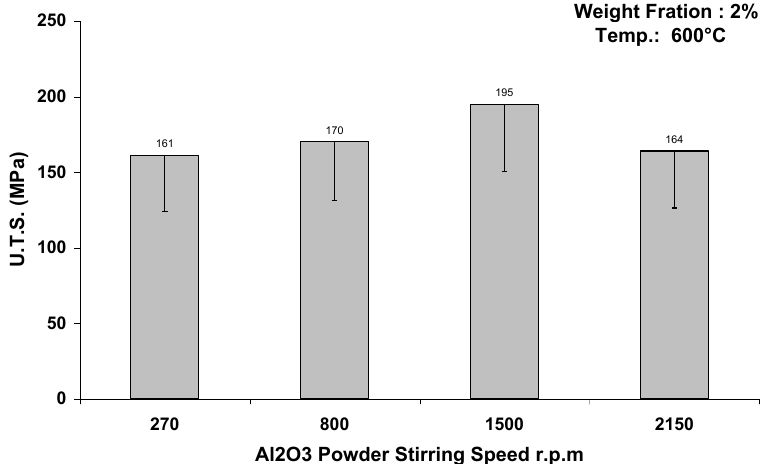
Figure 5. The effect of stirring speed on the UTS of 2 weight% Al 2 O 3 nanoreinforced alloy at 600 °C.